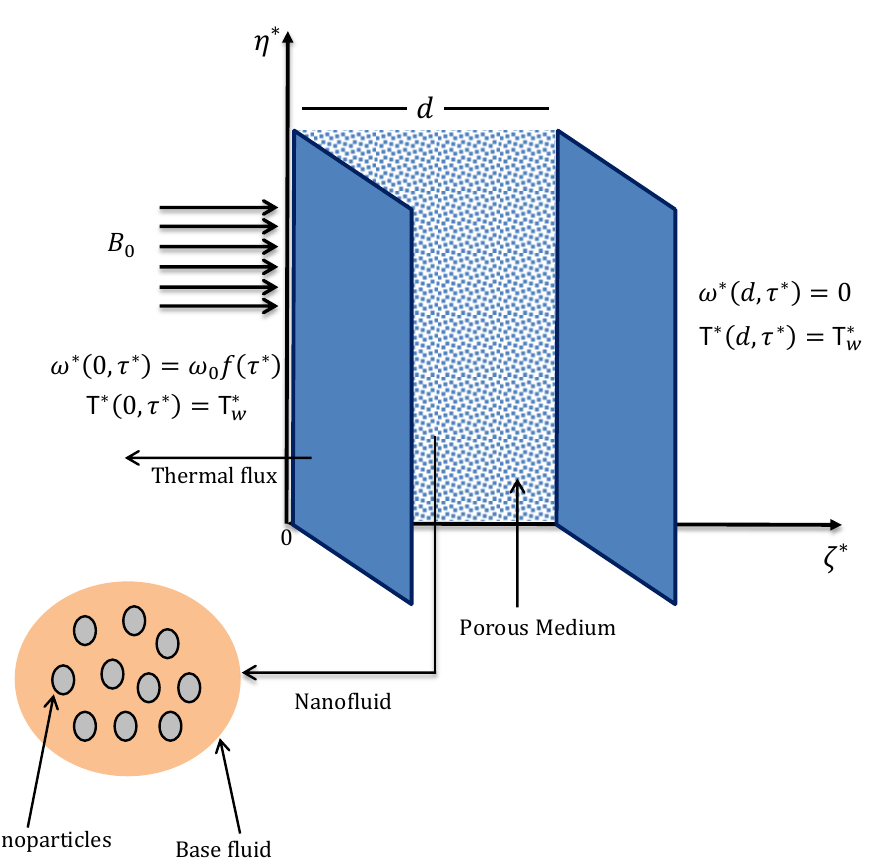
Figure 1. Geometrical model of the considered